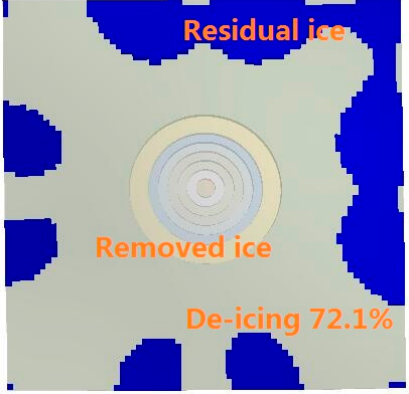
Figure 11. Equivalent stress.